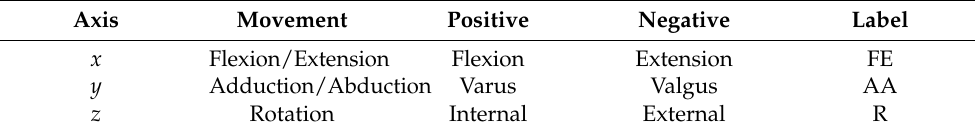
Table 2. Conventions used to represent knee moments.